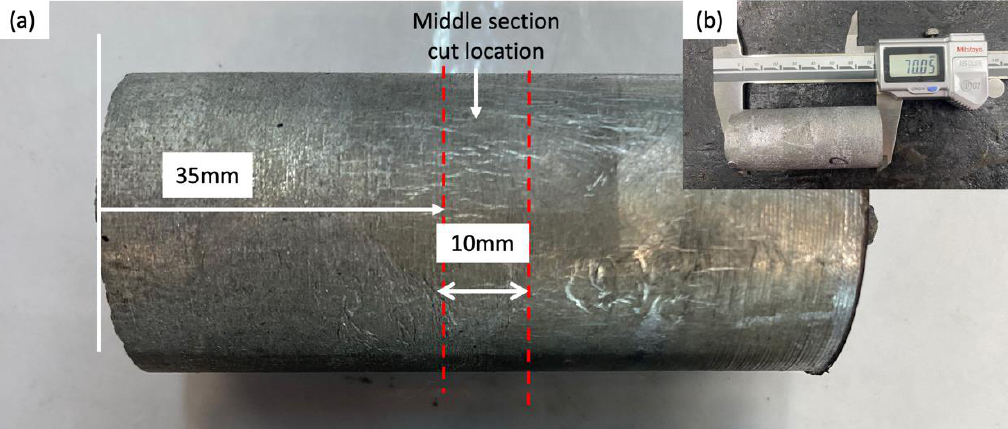
Figure 1. Whole sectional macrographs of thixoformed A356 aluminium matrix composite component reinforced by 0.3 wt.% GNPs ( a ) sample cut location; ( b ) whole length of billet composite (about 70 mm).